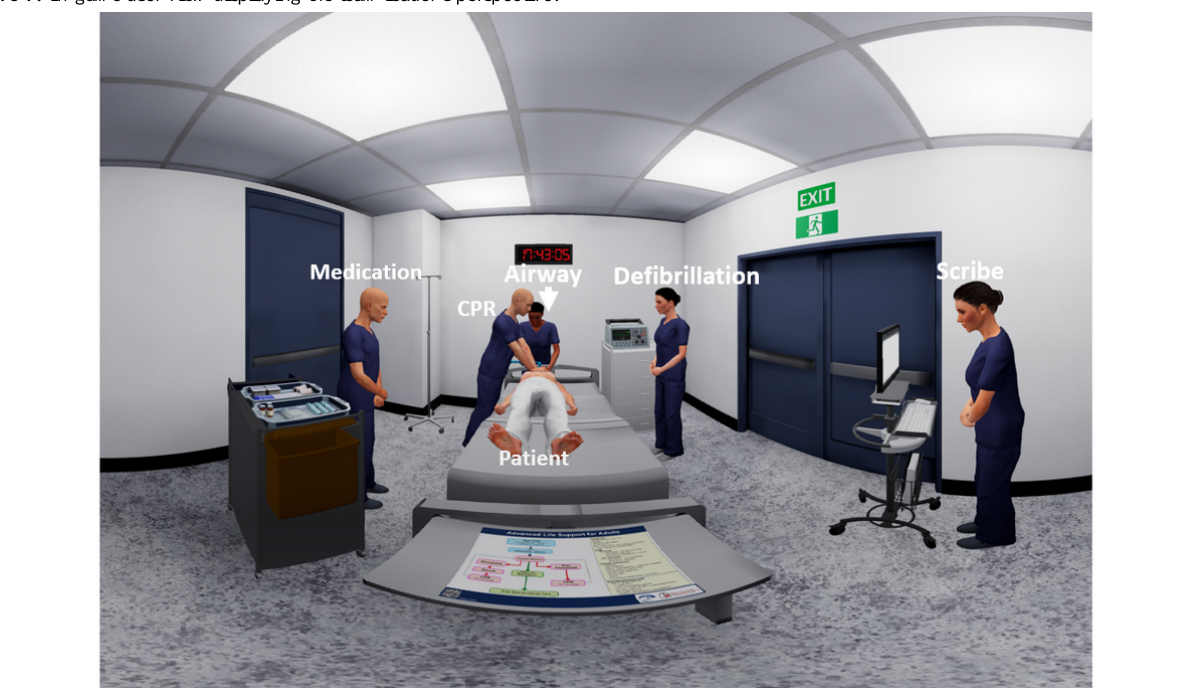
Figure 1. In-game user view displaying the team leader’s perspective.